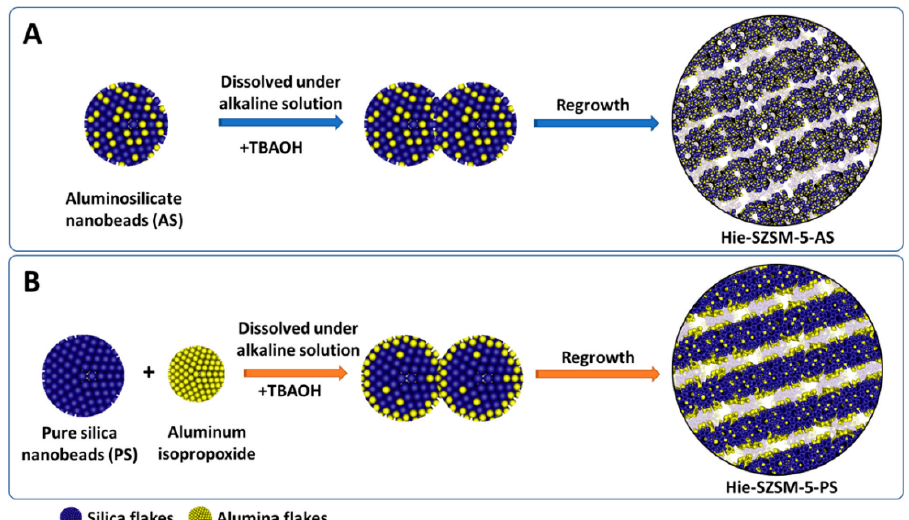
Figure 1. Proposed formation procedure of the ZSM-5 nanosheets with hierarchically nanospherical structure using different starting silica and alumina precursors: ( A ) aluminosilicate nanobeads (AS) and ( B ) pure silica nanobeads (PS) and aluminum isopropoxide as silica-alumina sources. Reprinted with permission from [23]. Copyright 2020 American Chemical Society.